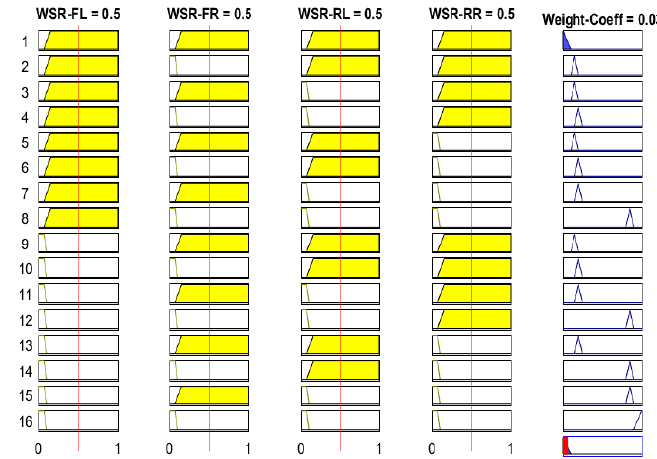
Figure 6. Final fuzzy logic algorithm.